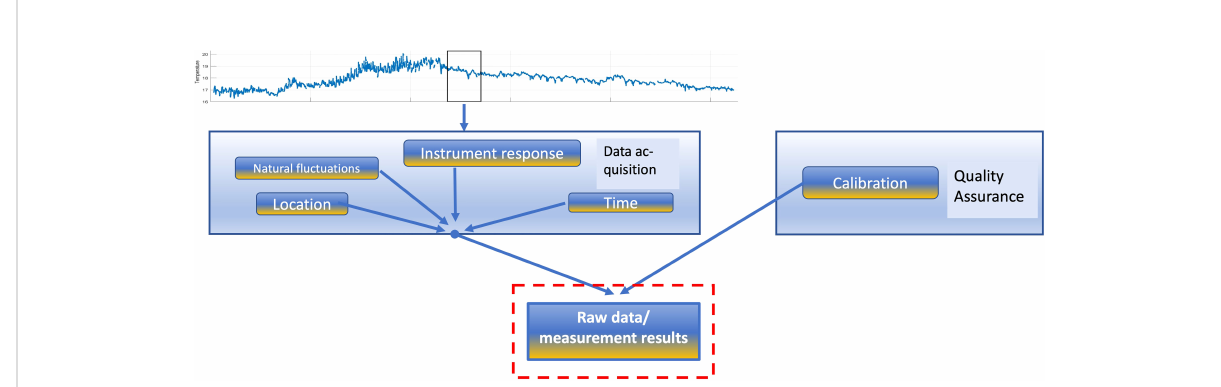
FIGURE 2 Schematic of information (blue) fl ow and their corresponding uncertainty (yellow) de fi ning a single fi eld measurement. The top part shows the environmental signal which is intended to be measured. The data acquisition box shows the different information and their uncertainty a measurement is facing: natural fl uctuations of the environmental signal between the selected sampling interval, the sensor response capabilities, related measurement of time facing clock drift or data storage delays, uncertainty of location because of movement within the water column or if bottom mounted, change of water depth due to tidal effects. The quality assurance box is representing the information an uncertainty from the sensor calibration as detected in the laboratory under stable and well-known